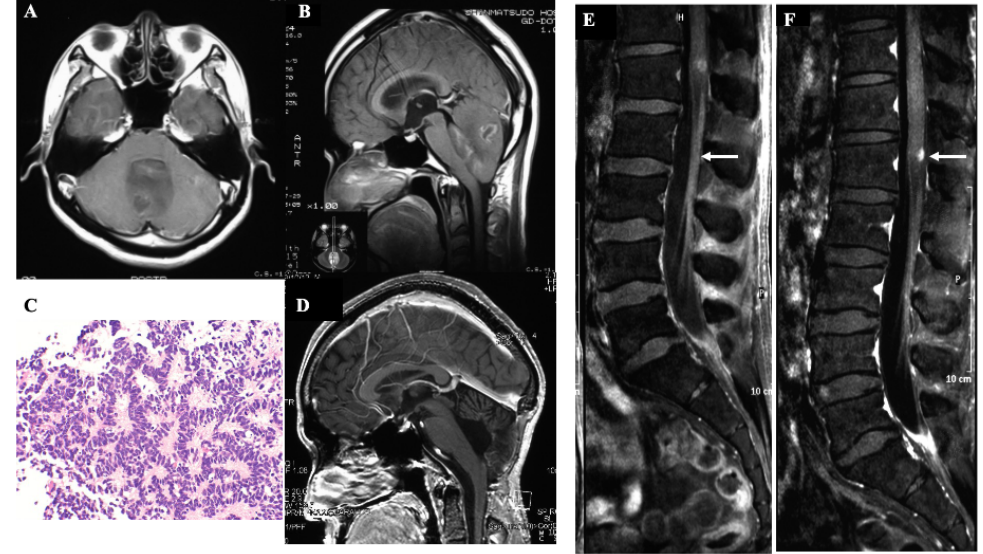
Figure 1. Radio-pathological findings of the patient before the lumbar surgery. ( A , B ): Preoperative gadolinium-enhanced T1-weighted MRI images of the brain displayed a heterogeneously enhanced tumor in the cerebellar vermis accompanied with obstructive hydrocephalus. ( C ): The histopatho- logical diagnosis of the tumor was a classic type medulloblastoma with abundant typical Homer- wright rosette in the hematoxylin and eosin stain (×100). ( D ): Postoperative gadolinium-enhance T1- wegihted MRI image of brain displayed subtotal resection of the cerebellar tumor. ( E , F ): Gadolin- ium-enhanced T1-weighted image of lumbar spine displayed a nodular enhanced mass (( F ): white arrow) with enhancement of meninges of cauda equina (( E ): white arrow).